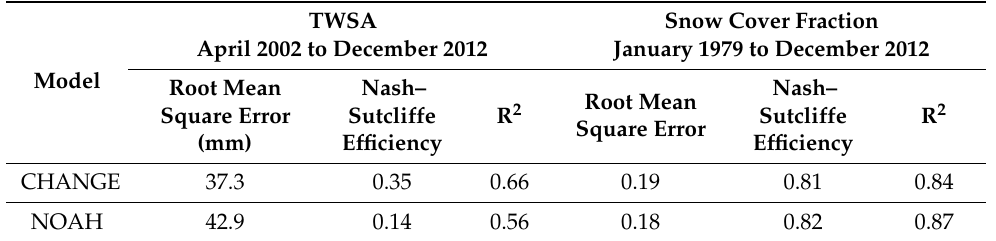
Table 2. List of long-term monthly model performance against satellite-based observation datasets.